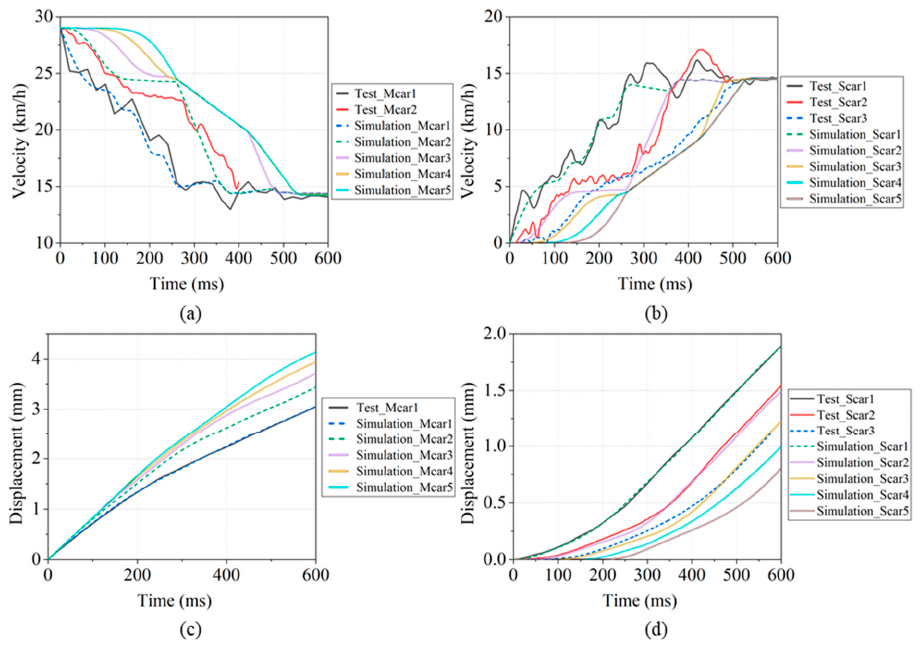
Figure 11. The movement of each vehicle during the collision. ( a ) Moving train velocity; ( b ) Stationary train velocity; ( c ) Moving train displacement; ( d ) Stationary train displacement.